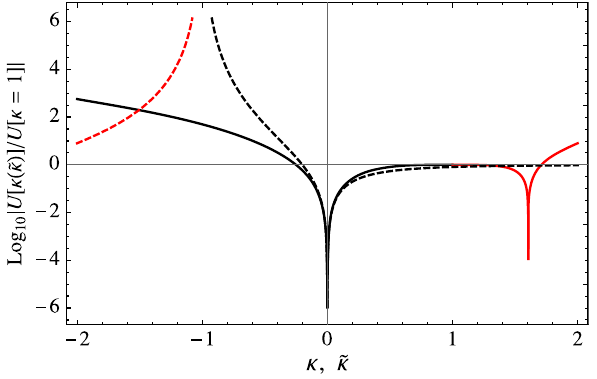
Fig. 2 Logarithmic plot of the normalized action polynomial as a functionofthe π -frameparameter κ (solidline)andthe ρ -framevariable ˜ κ = κ/( 1 − κ) (dashed line) in d = 4. Black lines indicate the region preserved by the duality transformation, and red lines indicate those regions mapped to the left of an infinite barrier in the ρ frame